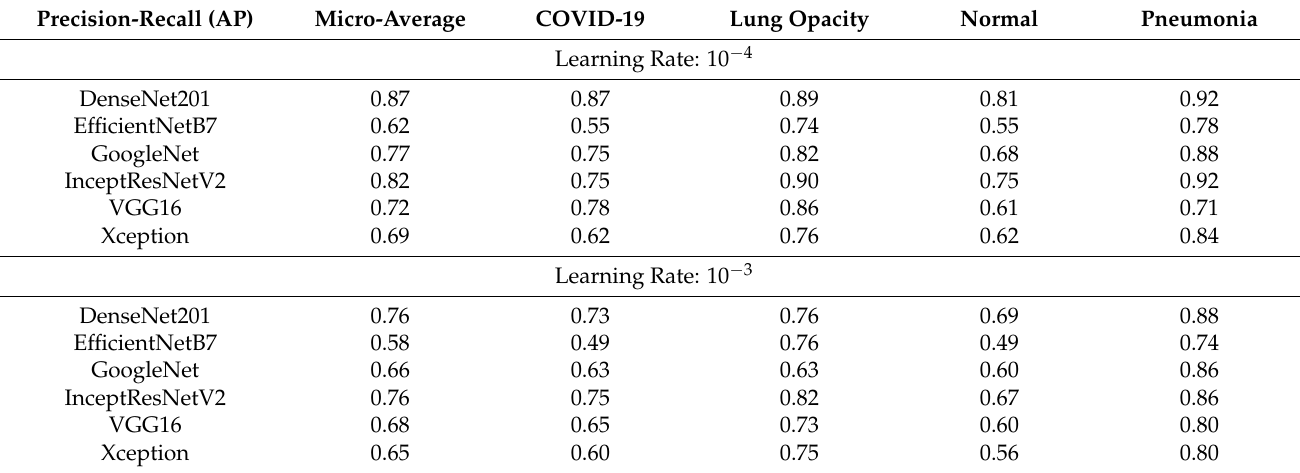
Table 6. Precision-recall curve of the backbone model using